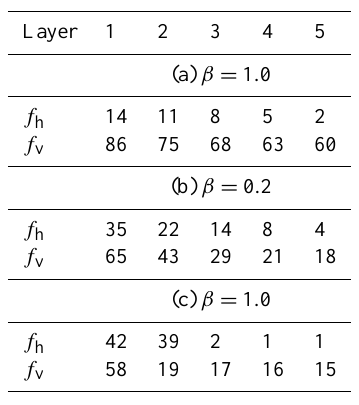
Table 2. Horizontal and vertical fluxes of the thought experiment detailed in Sect. 2.4.3 and shown in Figure 5 to illustrate the com- plex flushing parametrization. All fluxes are given in percent of total flushing ( P f h + f 5 v = 100). In (a) and (b), all five layers have the same permeability, while in (c) the top two layers are 20 times more permeable. The free parameter β is changed from the default value of 1.0 to 0.2 in